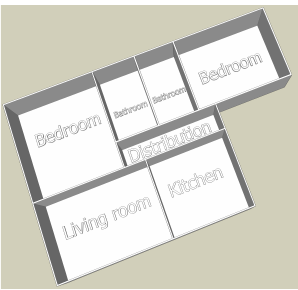
Figure 1. Scheme of the typical Italian dwelling considered.